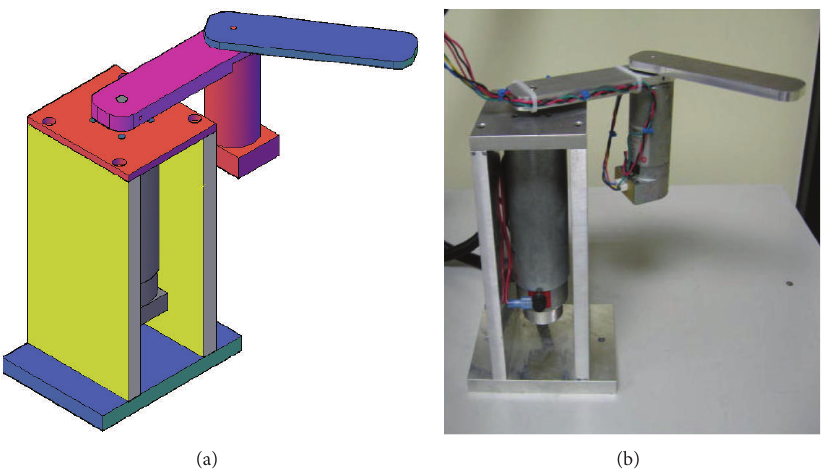
Figure 1: Experimental horizontal two-degree-of-freedom robot manipulator.